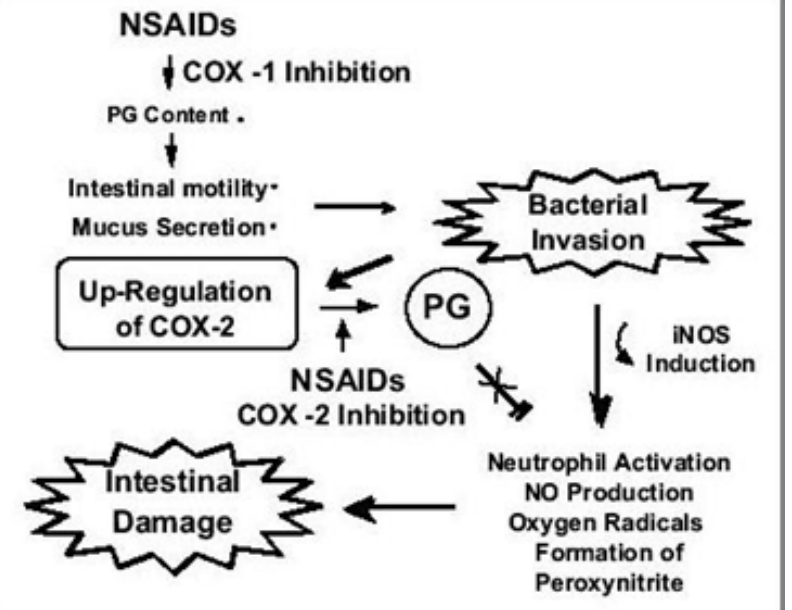
Figure 1. The potential pathogenesis of NSAIDS induced GI toxicity [36] . Adapted with permission from the